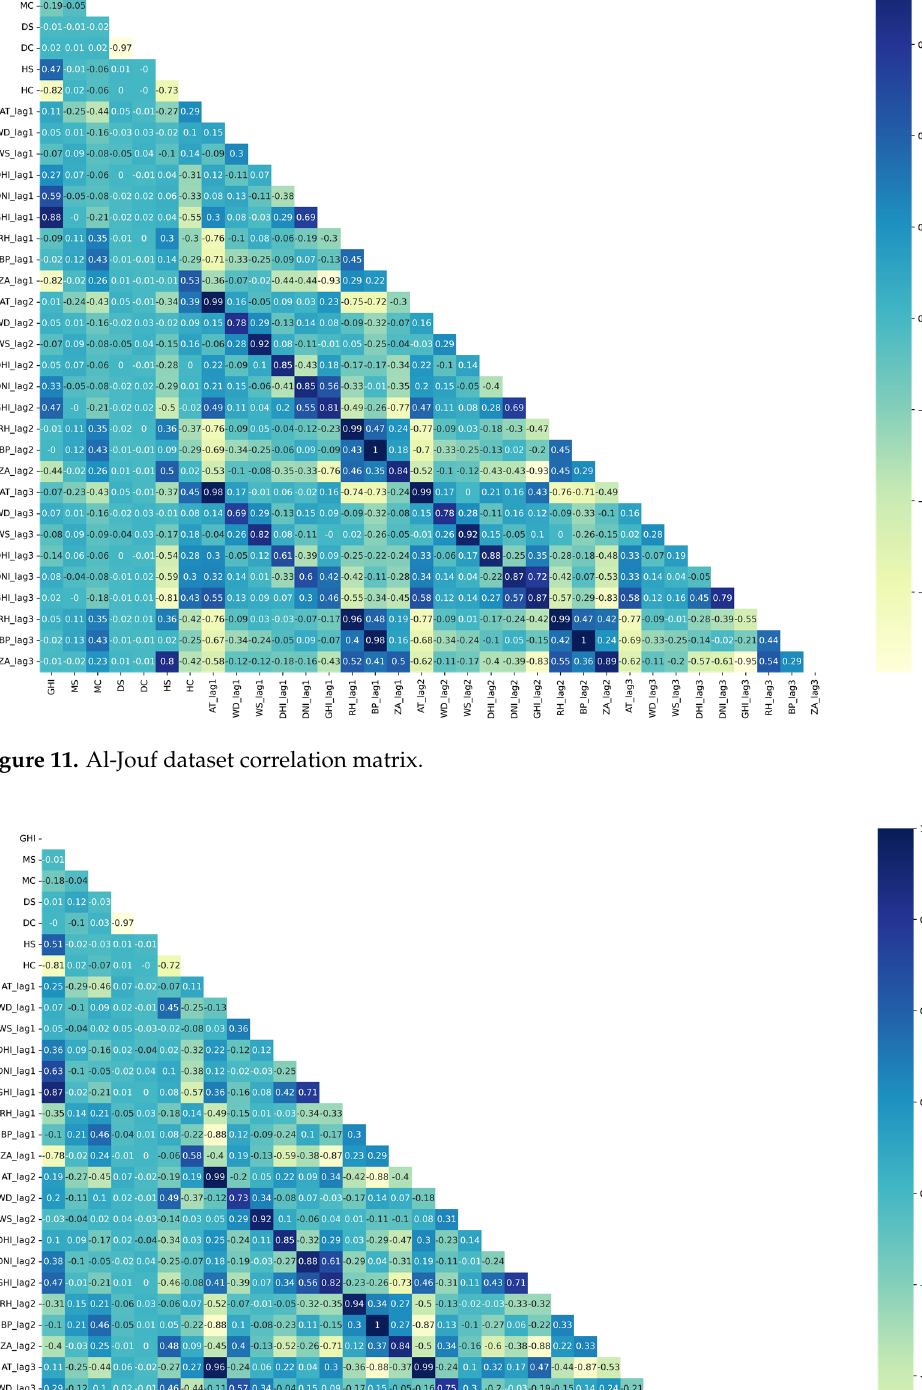
Figure 12. Al-Khafji dataset correlation matrix.